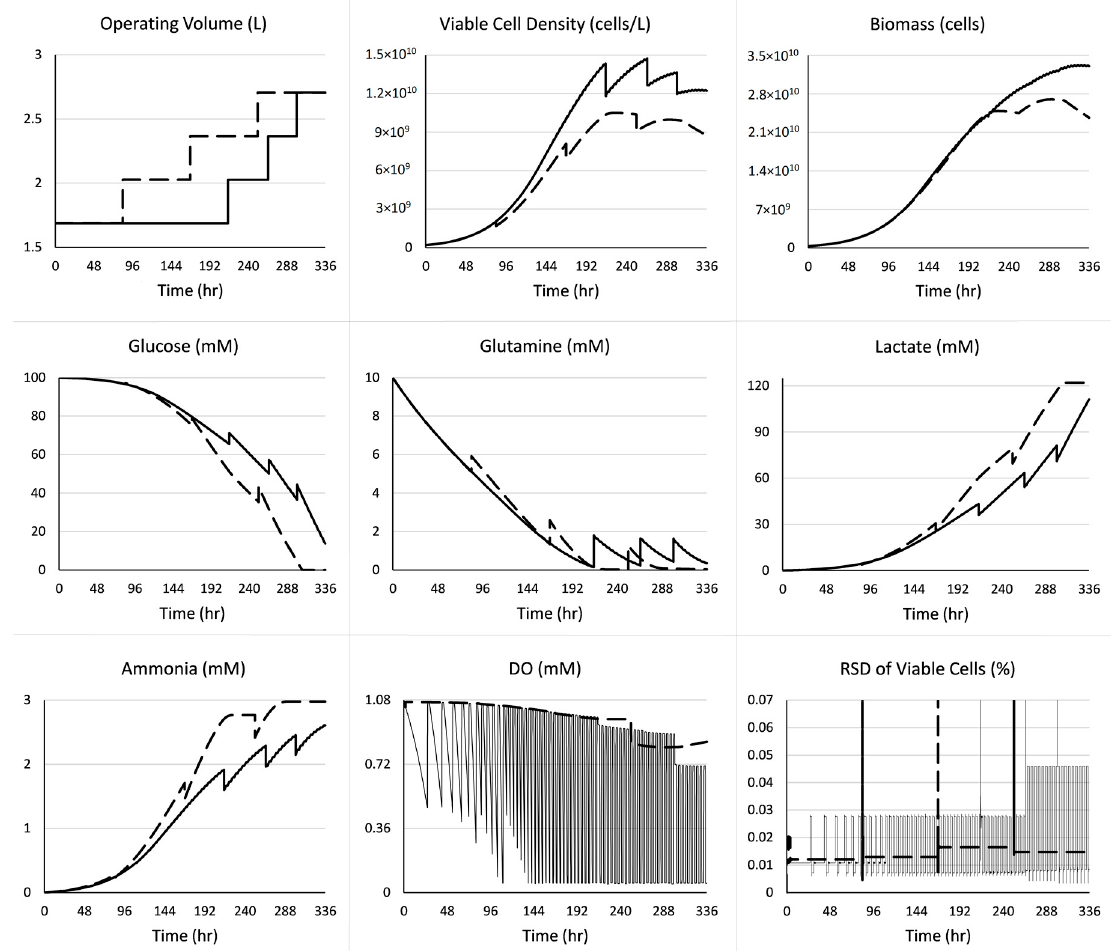
Figure 5. Comparison of two operational polices: near-optimal policy (solid lines); and alternative policy with uniform feeding schedule (dashed lines).